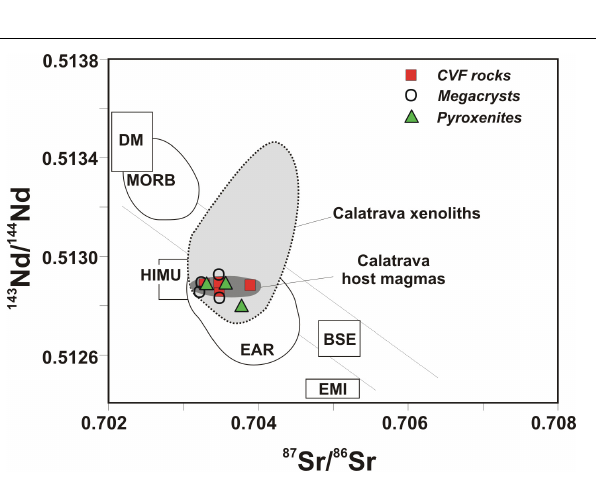
FIGURE 5 | 143 Nd/ 144 Nd vs 87 Sr/ 86 Sr ratios of volcanic rocks, megacrysts and associated pyroxenite enclaves from the Cerro Pelado and El Aprisco volcanoes (Calatrava Volcanic Field, CVF). Mantle-end members (DM, MORB, HIMU, BSE and EMI) are from Zindler and Hart (1986). EAR (European Asthenospheric Reservoir) after Downes et al. (2003). Calatrava peridotite xenoliths from Villaseca et al. (2010) and authors’ unpublished